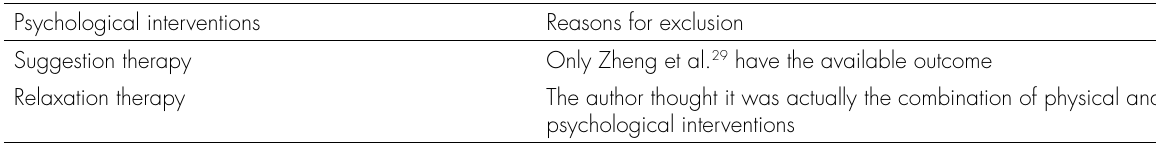
Supplementary Table III. The reasons our review did not contain other psychological